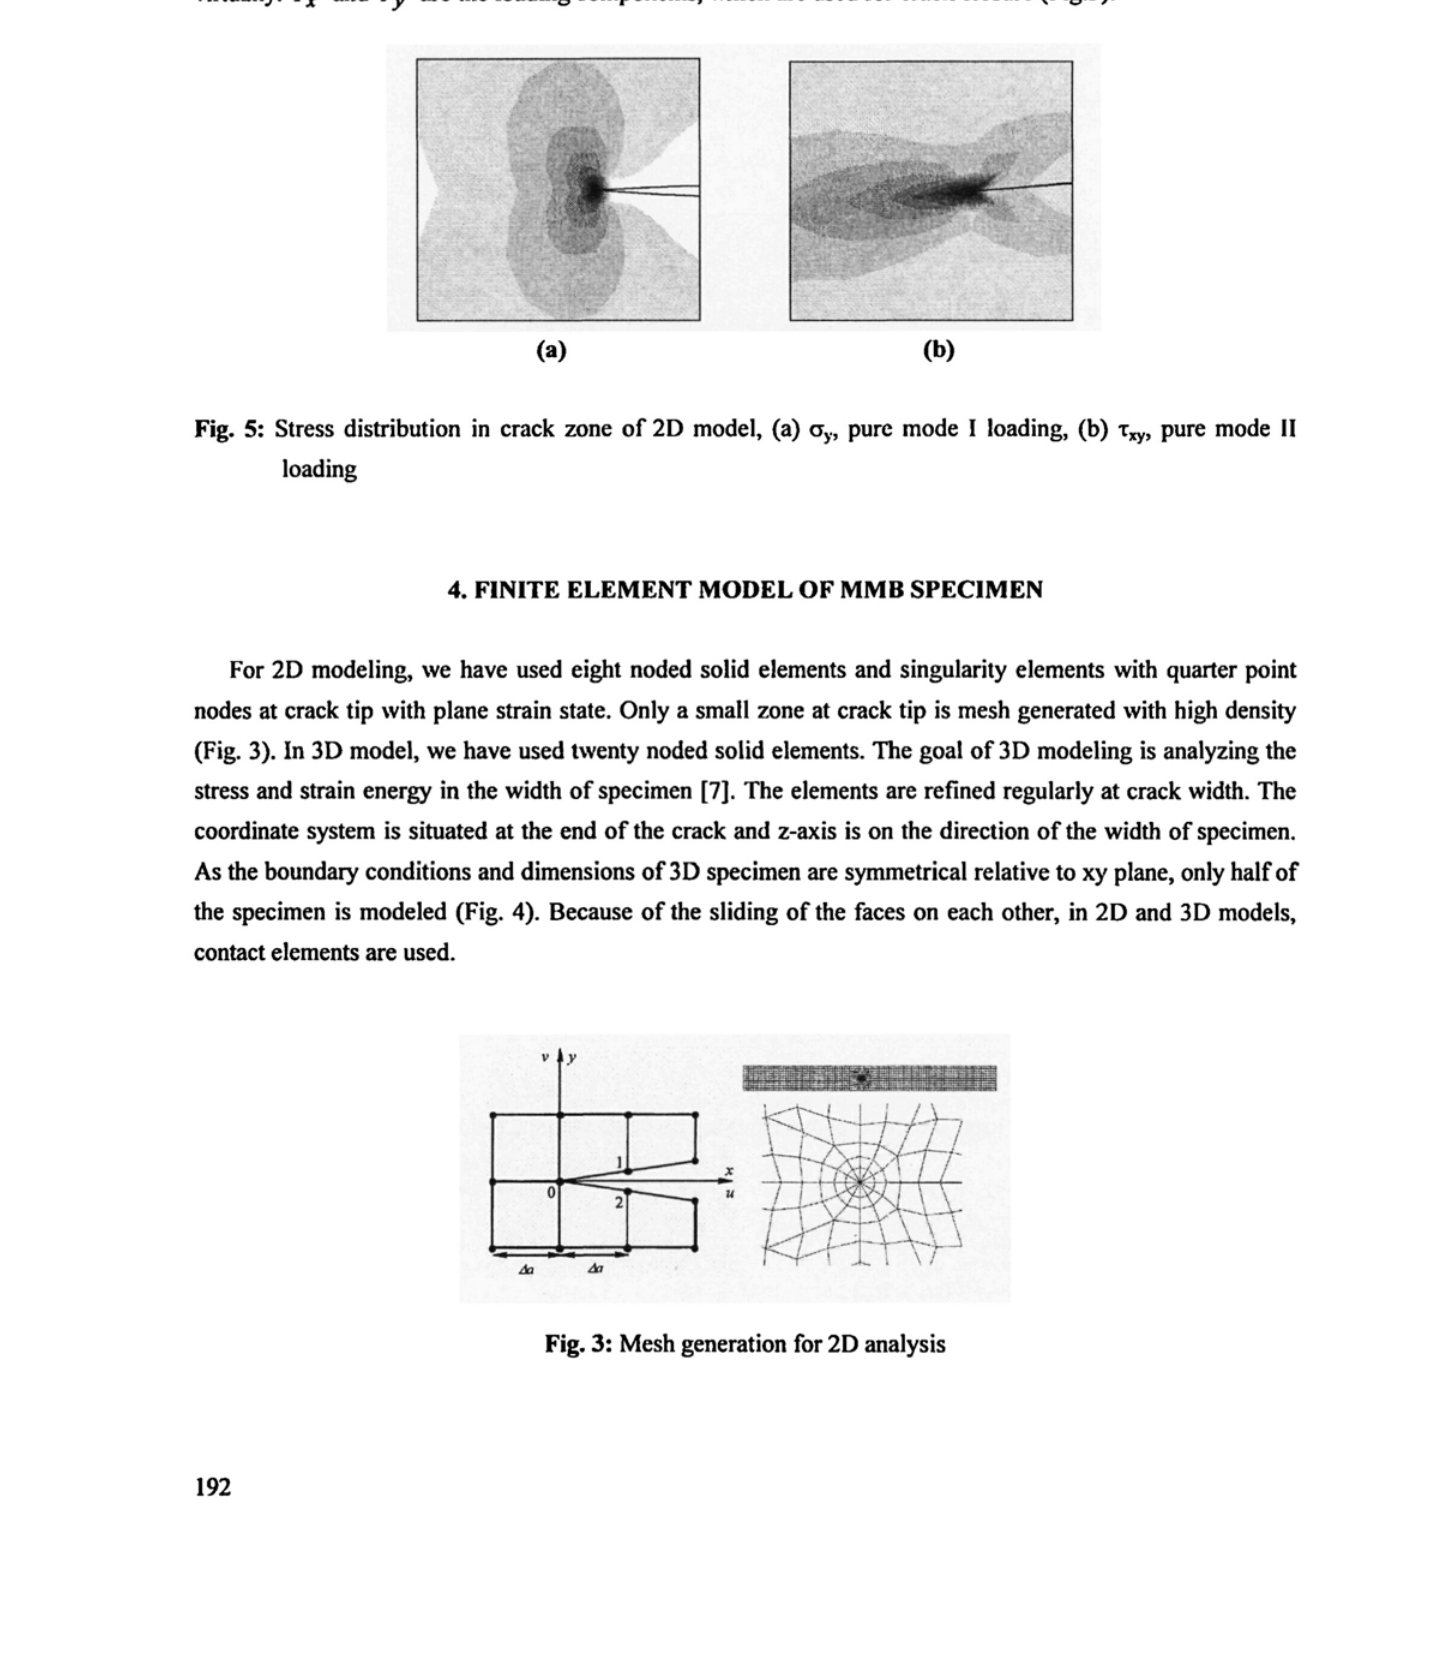
, pure mode I loading, (b) τ^, pure mode II y